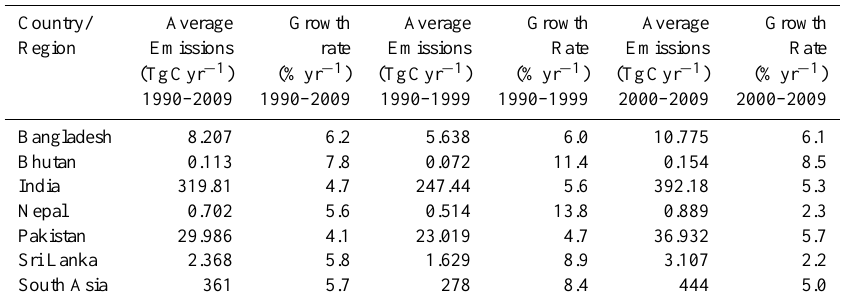
Table 1. Average fossil fuel CO 2 emissions and annual growth rates (%) for the decades of 1990s, 2000s, and the full RECCAP period (1990–2009). Country/ Average Growth Average Growth Average Growth Region Emissions rate Emissions Rate Emissions